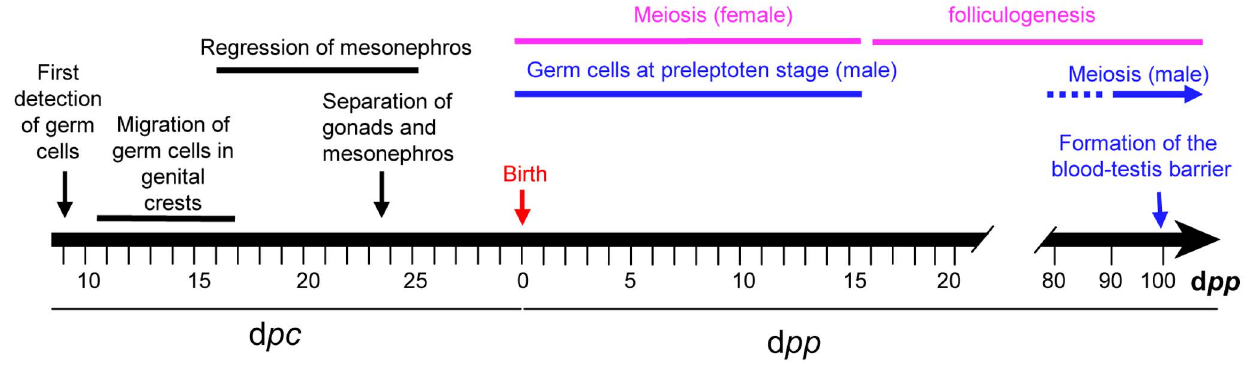
Figure 1. Schematic representation of the principal features of gonad differentiation in the rabbit species.